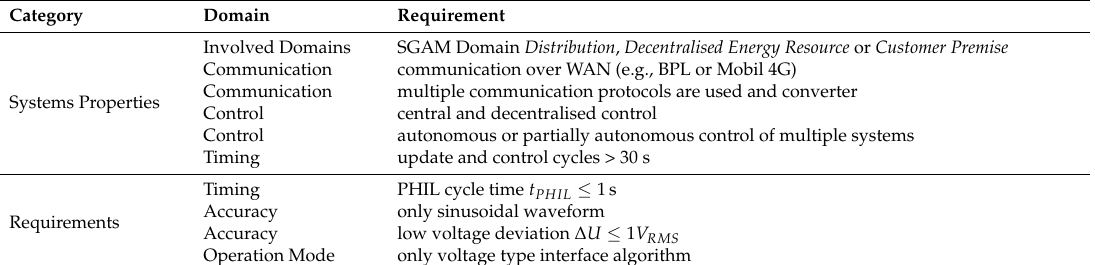
Table 3. Overview of the requirements for the proposed